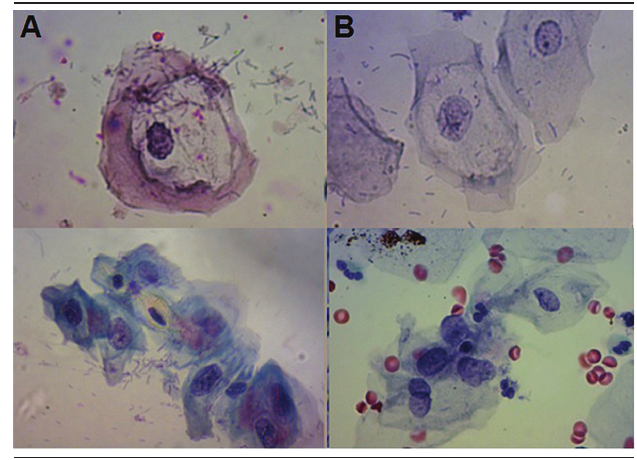
figura 5 − Anormalidades citológicas em células cervicais pelo exame de Papanicolaou (A) e preservadas em FIPLIQ após 15 dias. Papanicolaou, 400× FIPLIQ: fosfato de